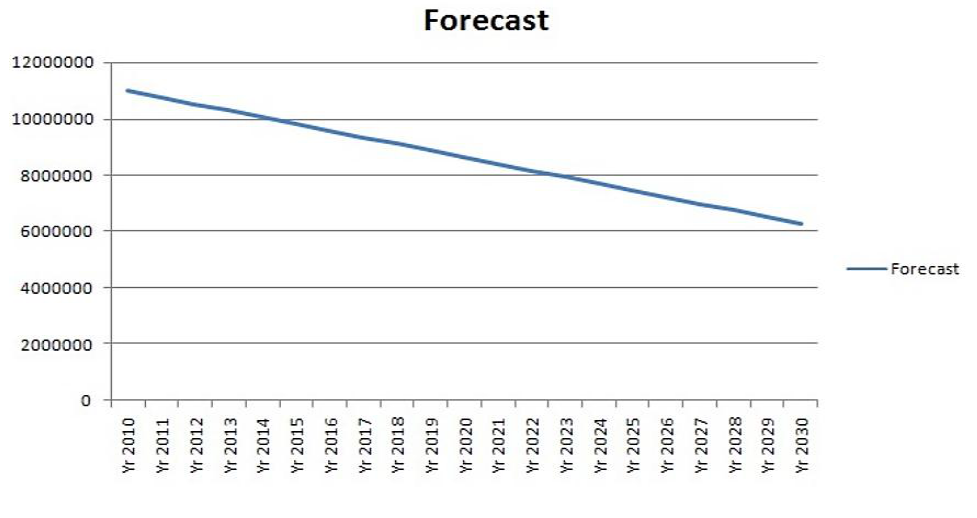
Figure 2. Forecast of Domestic Air Passenger Demand in Nigeria from Year 2010 to